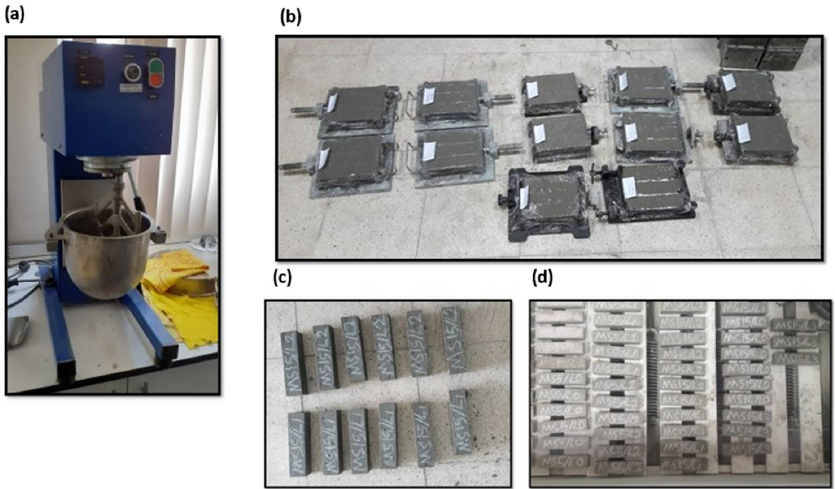
Figure 2. ( a ) Mixer, ( b ) casted mortar samples, ( c ) samples after demolding, ( d ) samples in the curing Figure 2. (a) Mixer, (b) casted mortar samples, (c) samples after demolding, (d) samples in the curing tank .